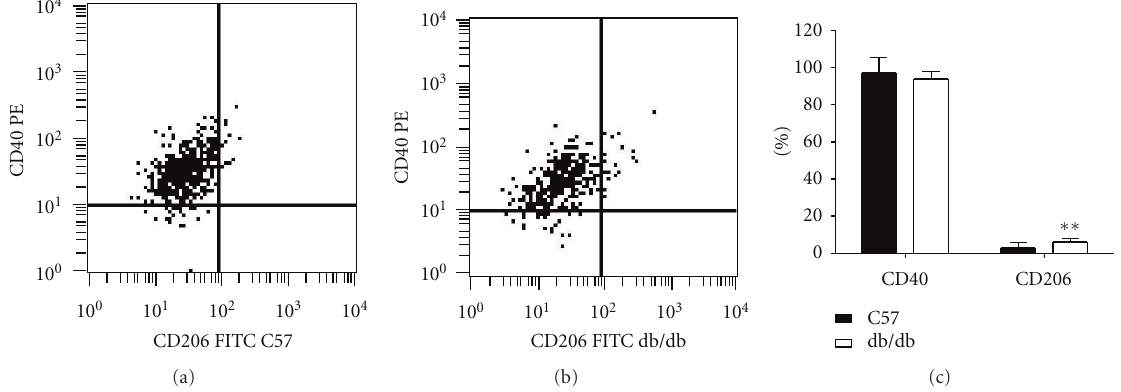
Figure 4: Increased percentage of M2 macrophages in RPMs from db/db mice. One representative example of four independent experiments with identical results is shown. (a) and (b) were RPMs from normal and db/db mice, respectively. And the average percentages of M1 and M2 macrophages were quantified (c). ∗∗ P < 0.01 versus control